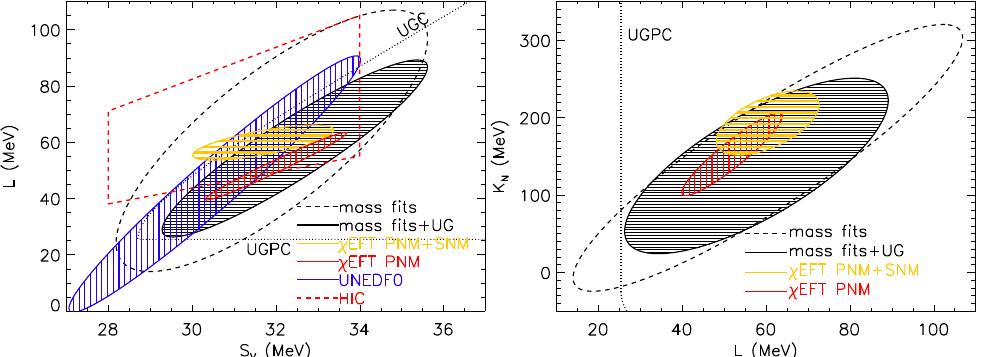
Figure 5. Black correlation ellipses for S V − L ( left panel ) and K N − L ( right panel ) use model inter- action data [34,36,37], with (solid) and without (dashed) application of Unitary Gas Constraints [35] boundaries (dotted). The blue confidence ellipse shows UNEDF [38] results assuming σ = 1.2 MeV. The red (brown) confidence ellipses are from chiral EFT studies [39] using PNM results with empir- ical saturation properties (combined PNM+SNM results). The red-dashed quadrilateral are limits determined from elliptic flows in heavy-ion collisions